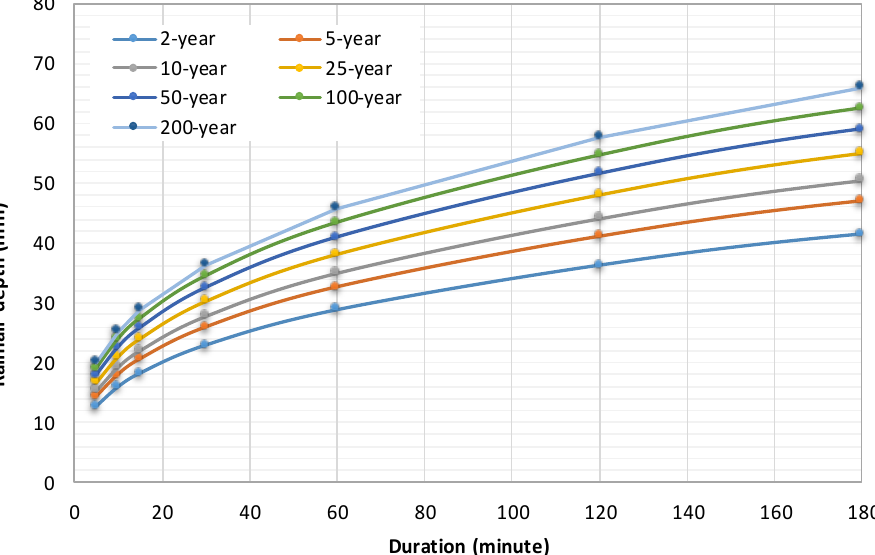
Figure 5. Depth duration frequency (DDF) for the Kesem watershed with rainfall estimation of seven return periods.